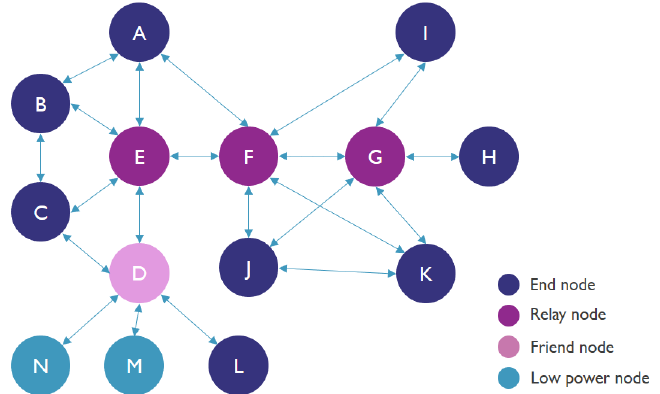
Figure 2. An example of a BLE mesh network.